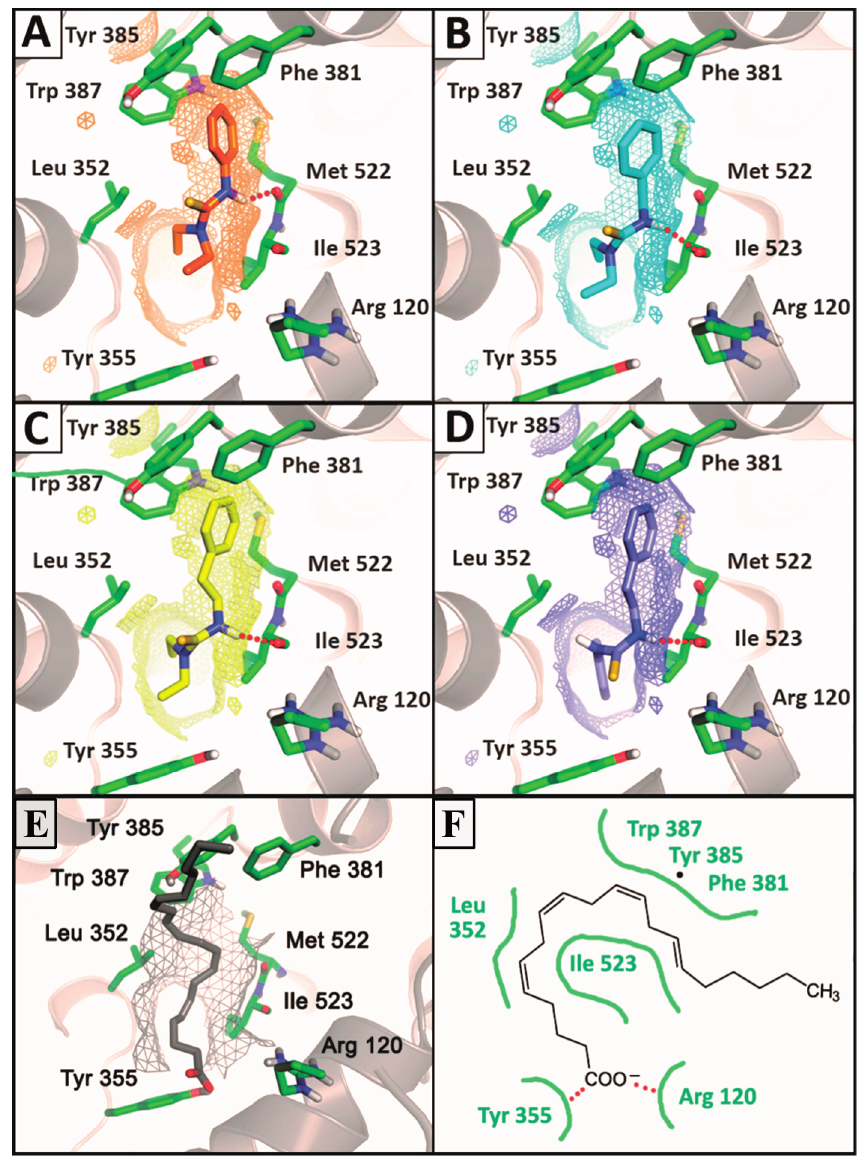
Figure 5. Comparison of the most stable poses observed for the active compounds 3d ( A ), 3i ( B ), 3m ( C ), 3p ( D ) and arachidonic acid ( E , F ) with the crystallographic structure of ovine COX-1 (PDB ID: 2OYE). Hydrogen bounds are shown as red